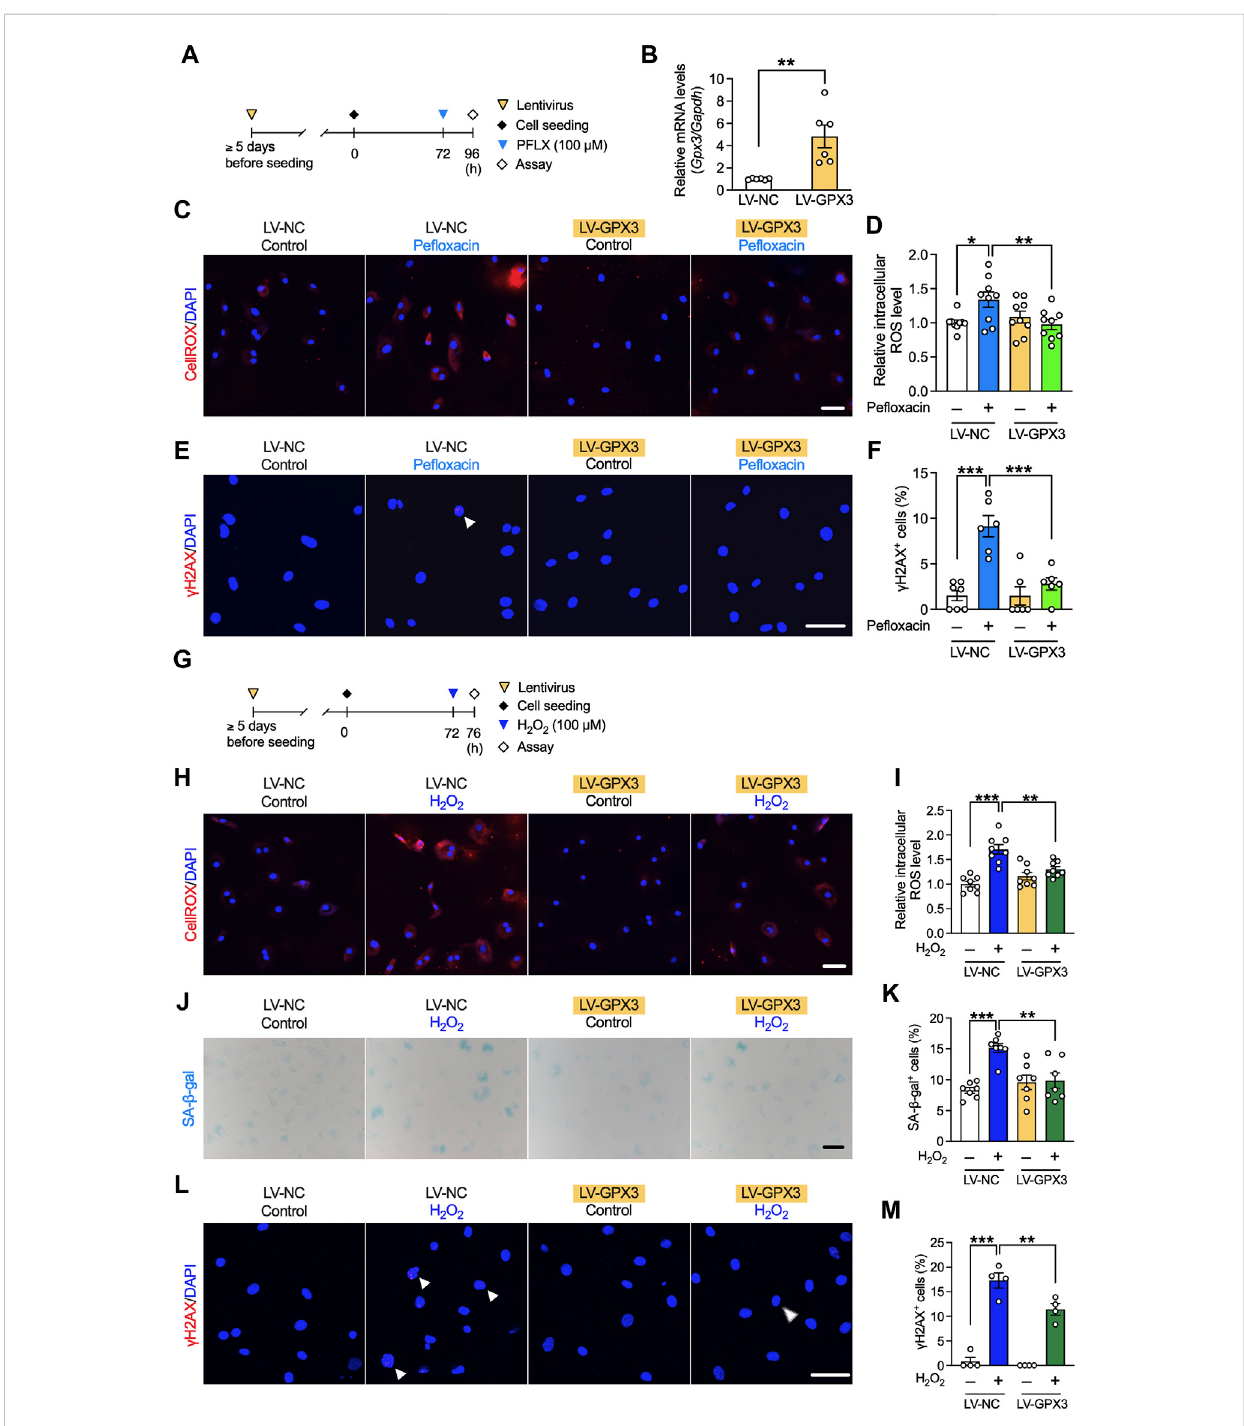
FIGURE 7 Effects of GPX3 on pe fl oxacin-induced oxidative stress and hydrogen peroxide-induced senescence in rat primary tenocytes. (A) Tenocytes transducedwithlentivirusfor overexpressing GPX3(LV-GPX3) ornegativecontrol(LV-NC). (B) The geneexpression of Gpx3 after lentiviralinductionwas examined using quantitative RT-PCR ( n = 6 per group) and represented as the relative ratio to the LV-NC group. (C,D) The levels of reactive oxygen species (ROS) were evaluated using the CellROX assay ( n = 9 per group), and cells were imaged using confocal microscopy. The intensity of fl uorescence was measured in each cell. (E,F) Tenocytes were stained with anti- γ H2AX antibodies ( n = 6 – 7 per group). The number of cells with three or more γ H2AX + foci (shown with arrowhead) is presented as a percentage of the total number of cells. (G) To create a stress-induced senescence model, tenocytes were treated with H 2 O 2 (100 µM, 4 h). (H,I) The levels ofROS wereevaluated using theCellROX assay ( n = 8per group). (J,K) SA- β -gal staining was performed ( n = 7 per group); the number of SA- β -gal + cells are presented as a percentage of the number of total cells. (L,M) Cells were stained with anti- γ H2AX antibody ( n = 4 per group). The number of cells with three or more γ H2AX + foci (shown with arrowhead) is presented as a percentage of the total number of cells. Data are shown as mean ± SEM. Statistical signi fi cance was tested using a two-way ANOVA with post hoc multiple comparisons; * p < 0.05, ** p < 0.01, *** p < 0.001. Scale bar; 50